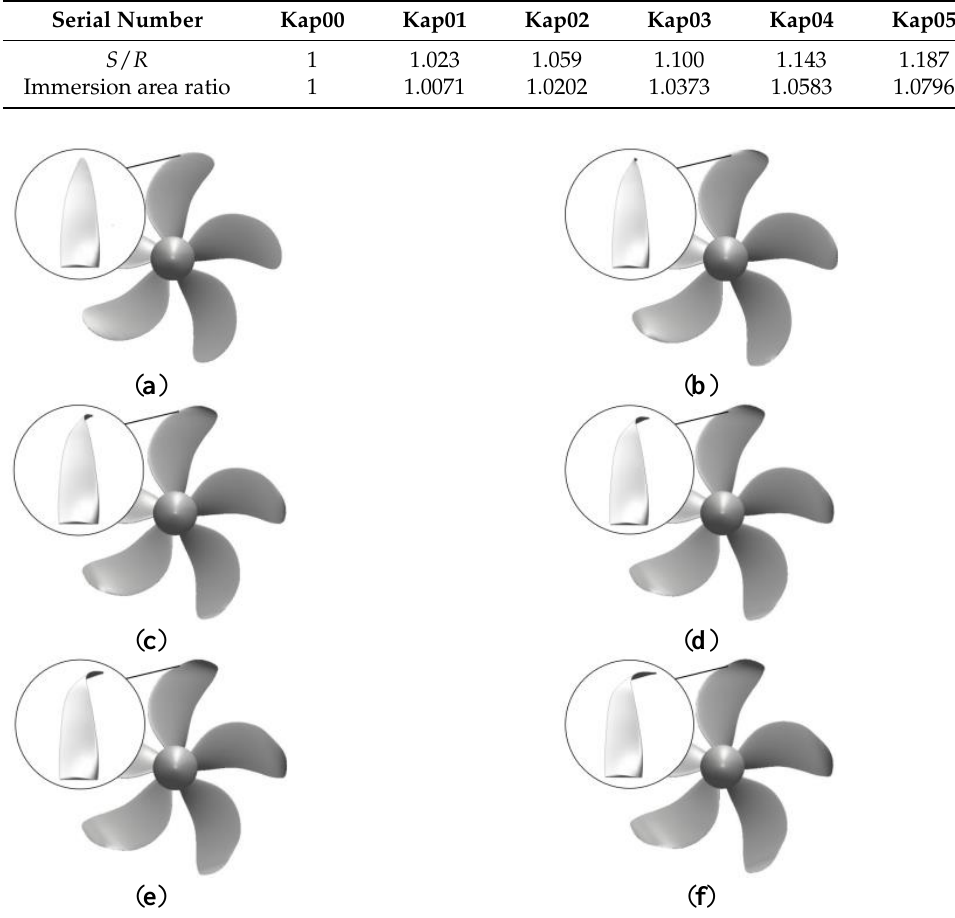
Figure 3. Three-dimensional models of Kappel propellers with different tip rakes, Kap00 ( a ), Kap01 ( b ), Kap02 ( c ), Kap03 ( d ), Kap04 ( e ) and Kap05 ( f ). Table 2. Basic geometric parameters of the reference propeller